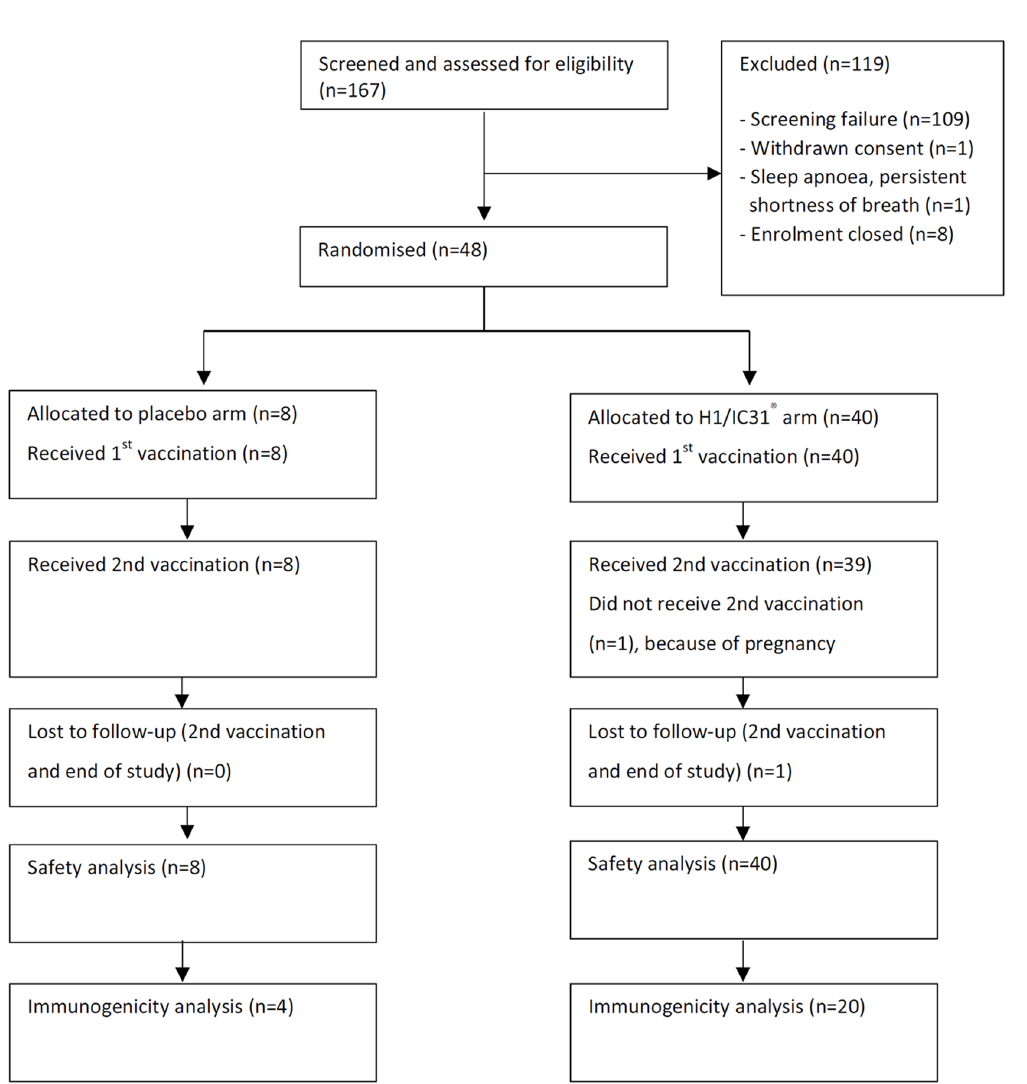
Fig. 1. CONSORT diagram of subjects for screening, exclusions, randomisation, vaccination and follow-up in the vaccine